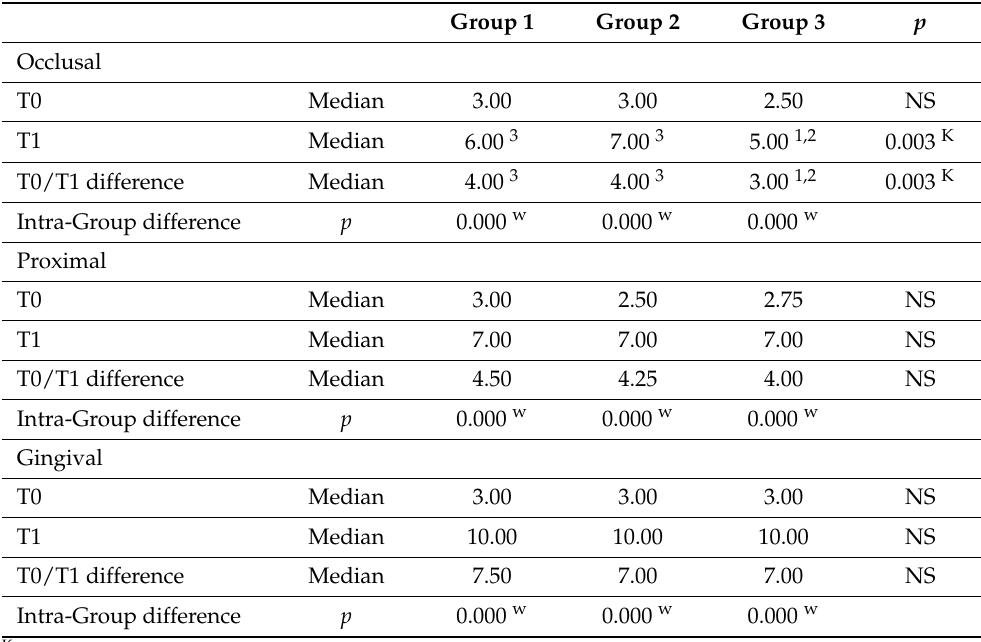
Table 2. Demineralization values on the enamel surface adjacent to the brackets at T0, T1 and T0/T1 periods.